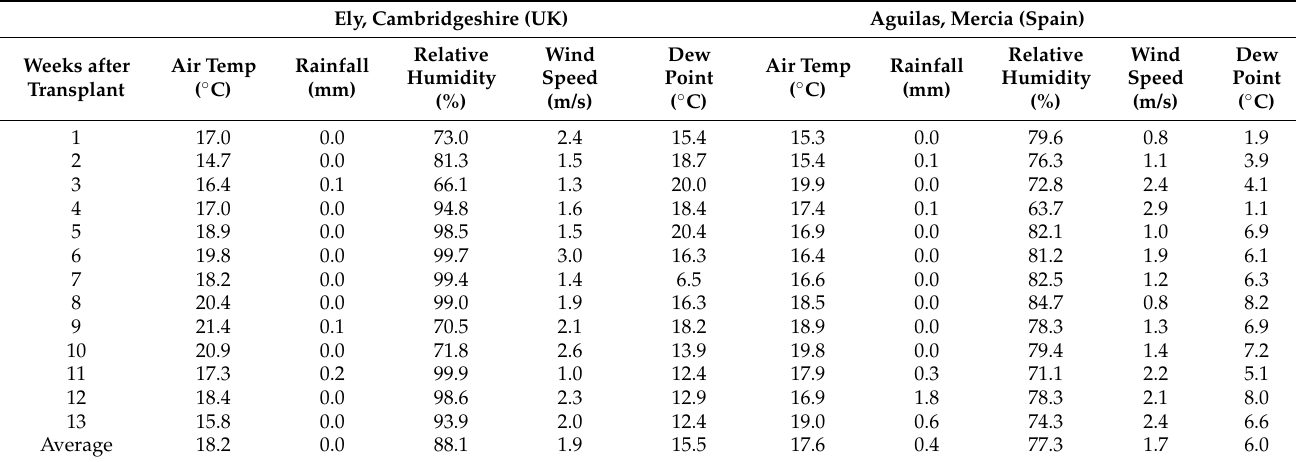
Table 3. Environmental data recorded at the nearest weather station to the farm of growth and provided by G’s Fresh (UK) and Grupo G’s